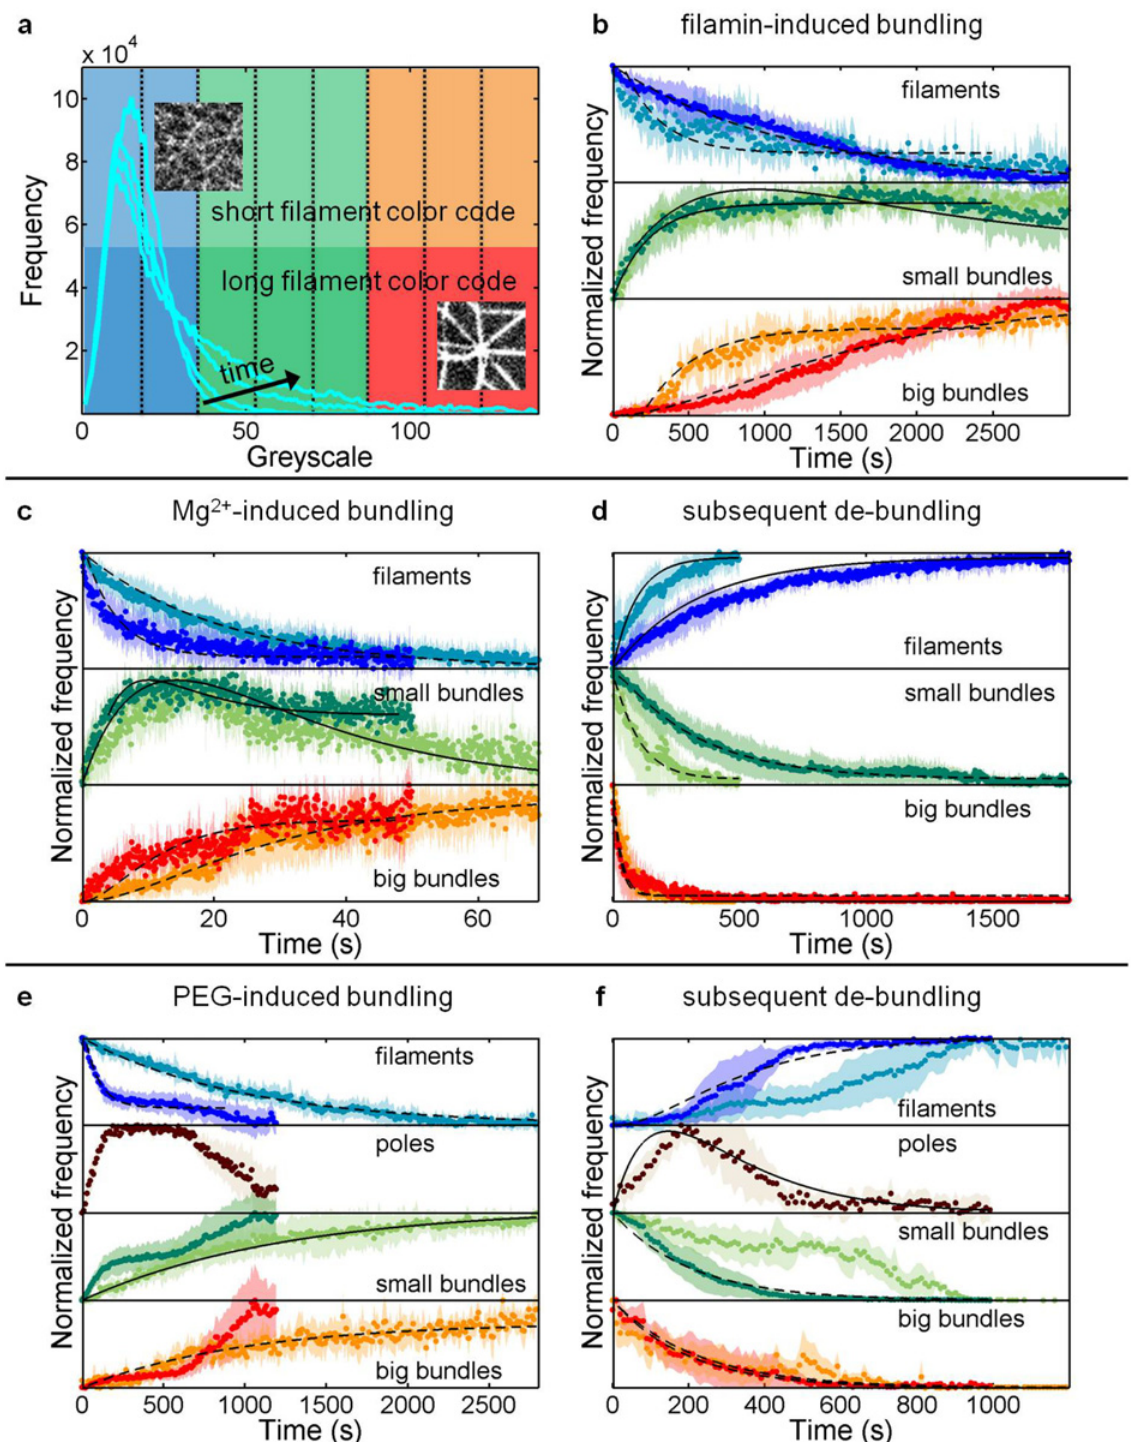
Fig 5. Evolution of filaments, small bundles and big bundles during the assembly and subsequent disassembly processes induced by counterion condensation, depletion interactions and specific binding interactions. (a) Typical frequency histograms (cyan) of greyscale values of the fluorescence images during the bundling process. The greyscale is divided into eight equal slices (indicated by vertical dotted lines) from which the evolution of the reaction components (b-f) is obtained. Similar scenario is applied to the de-bundling processes. (b, c, e) Evolution of reaction components during bundling induced by filamin ( n = 12), Mg 2+ ions ( n = 21) and PEG polymers ( n = 13), respectively. (d, f) Evolution of reaction components during de-bundling of